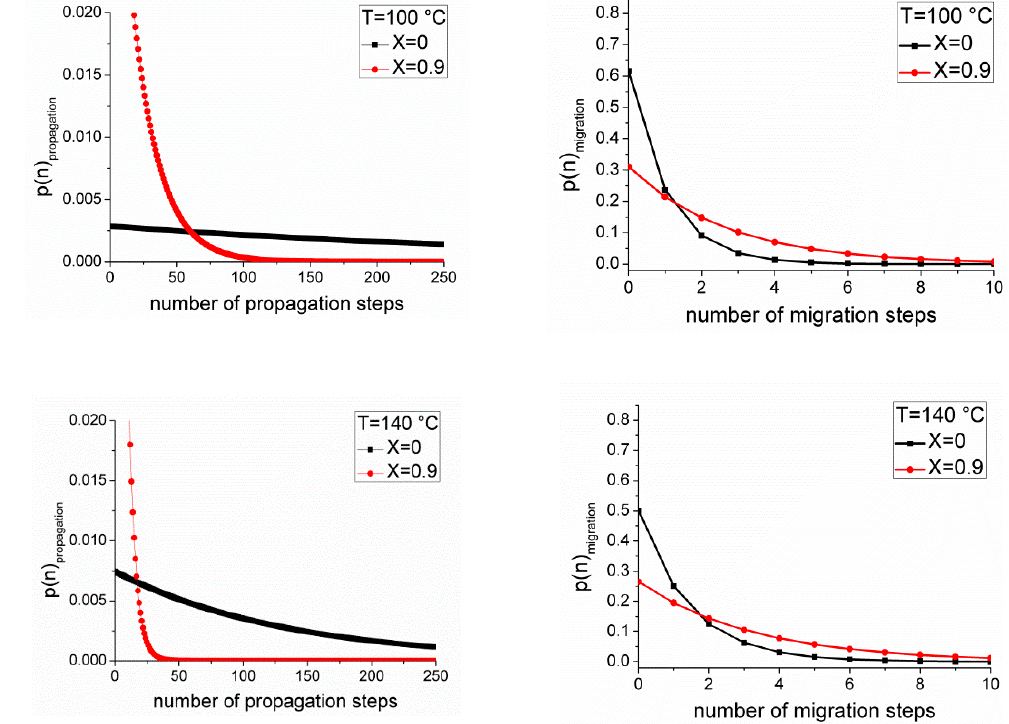
Figure 4. Comparison of instantaneous chain length distribution with distribution of number of radical migration steps at varying points of solution polymerization of butyl acrylate ([ M ] 0 = 3.9 M ) at 60 °C, 100 °C and 140 °C.